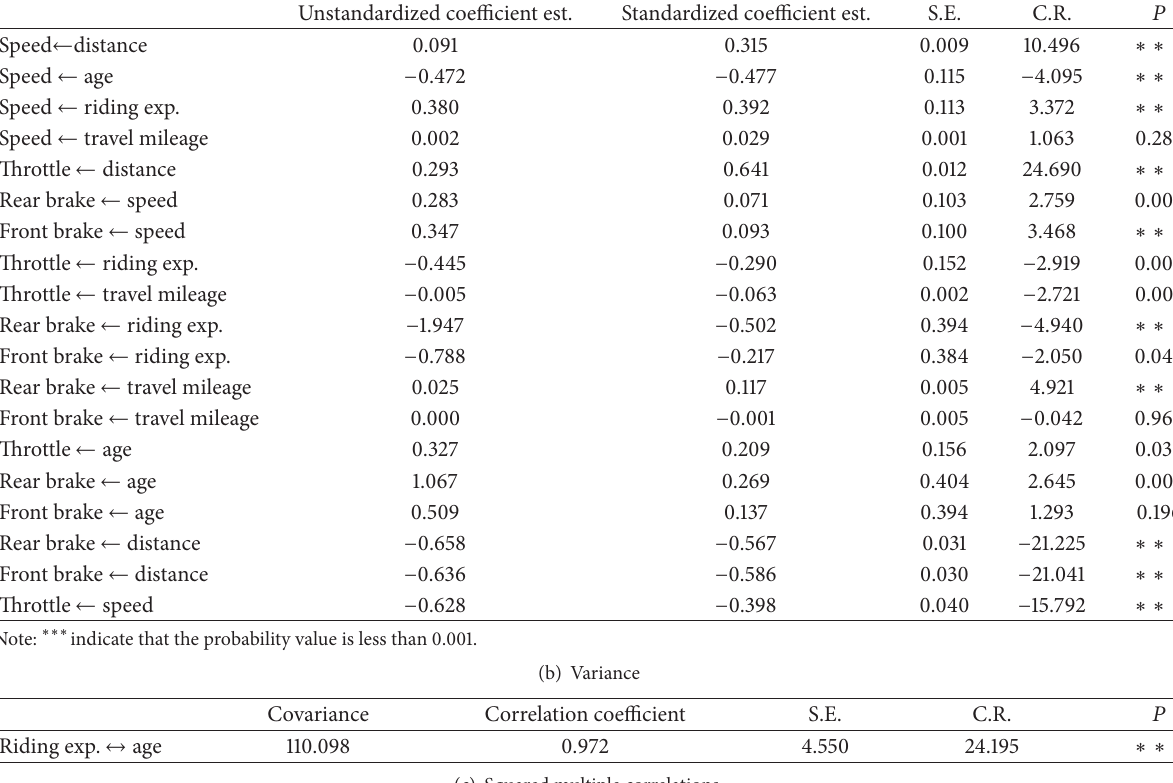
Table 3: Regression weights, standardized regression weights, variance, and squared multiple correlations. (a) Regression weights and standardized regression weights Unstandardized coefficient